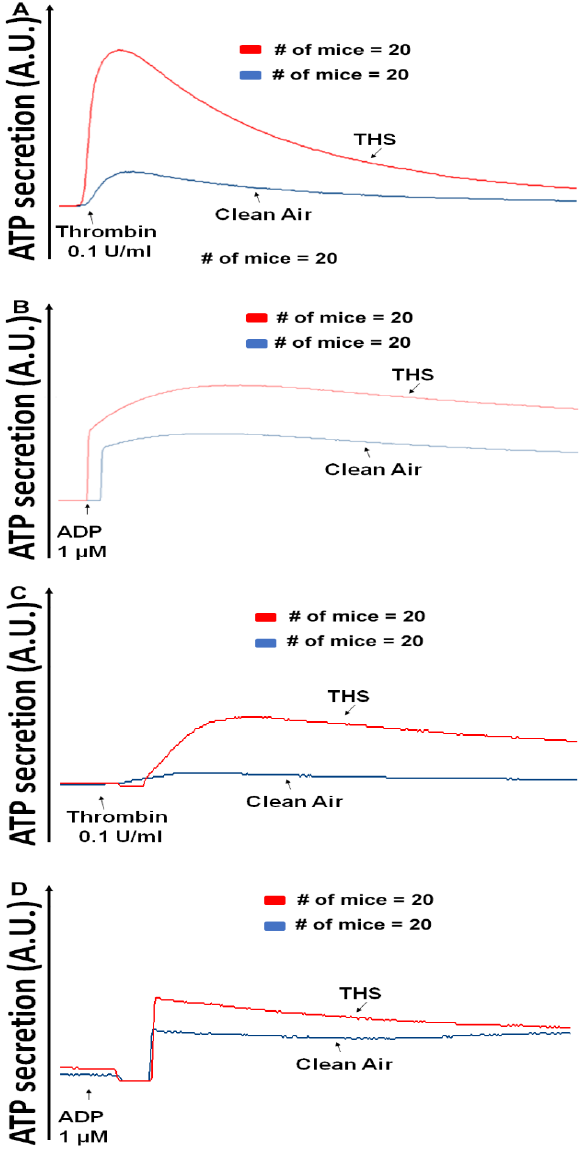
Figure 2. THS-exposed platelets show increased dense granule secretion. THS-exposed and CA- exposed platelets from male ( A , B ) and female ( C , D ) mice were stimulated with either ( A , C ) throm- bin (0.1 U/mL) or ( B , D ) ADP (1 μ M). Each experiment was repeated four times with blood